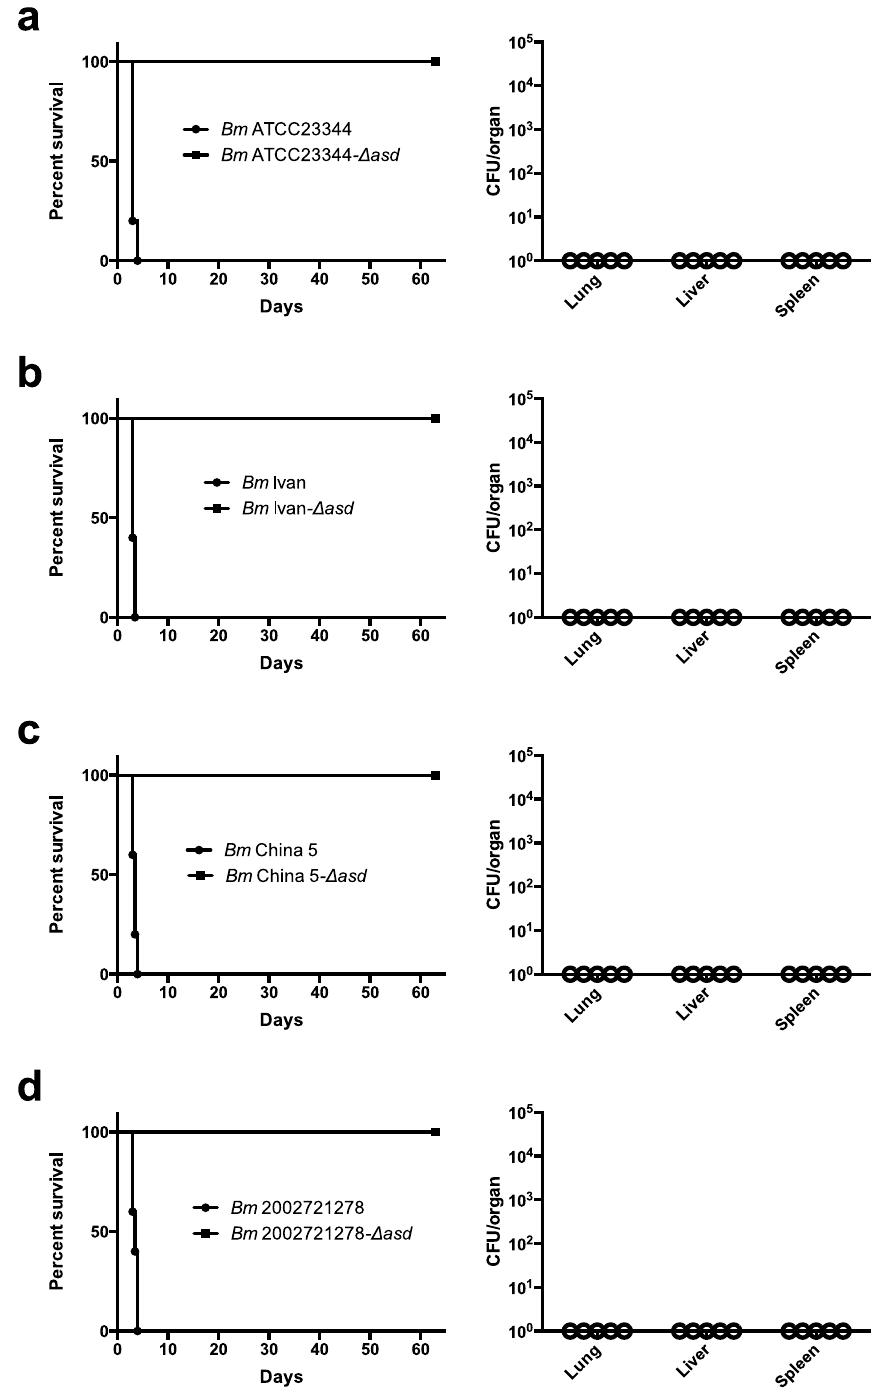
Figure 5. In vivo attenuation of Bm Δ asd strains in BALB/c intranasal challenge. BALB/c mice (n = 5) were challenged intranasally with 1 × 10 7 CFU of Bm strains ATCC23344 (a) , Ivan (b) , China 5 (c) , 2002721278 (d) and their Δ asd counterparts. Survival was monitored for 63 days (left panels). Surviving mice were sacrificed and bacterial burdens from the lungs, liver, and spleen were determined by serial dilution and plating (right